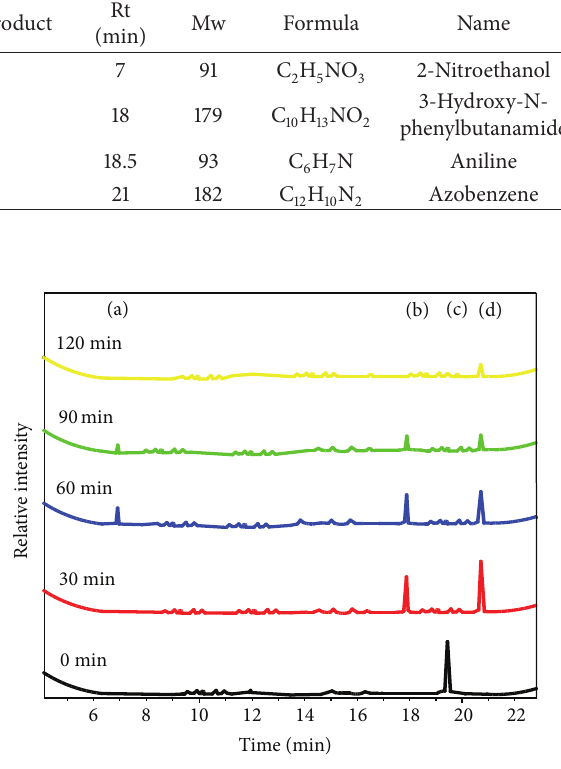
Figure 6: GC chromatograph of intermediates. (a) C 2 H 5 O 3 N,